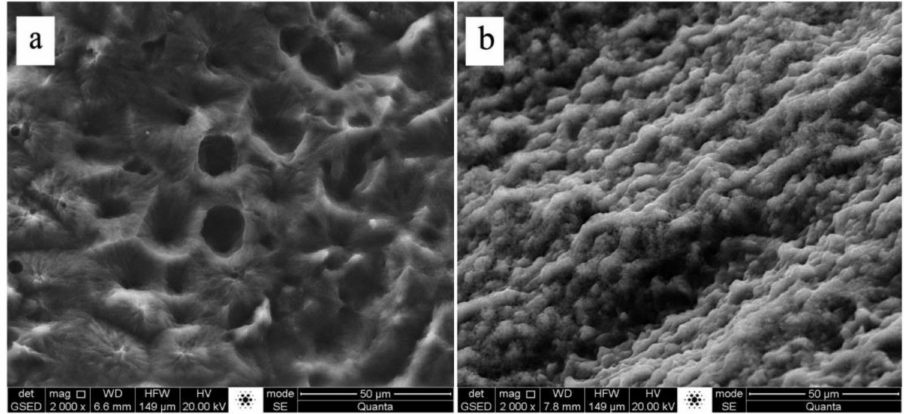
Figure 5. ESEM observation of: ( a ) surface of raw PCL; and ( b ) biofilm attached on PCL at HRT of 1